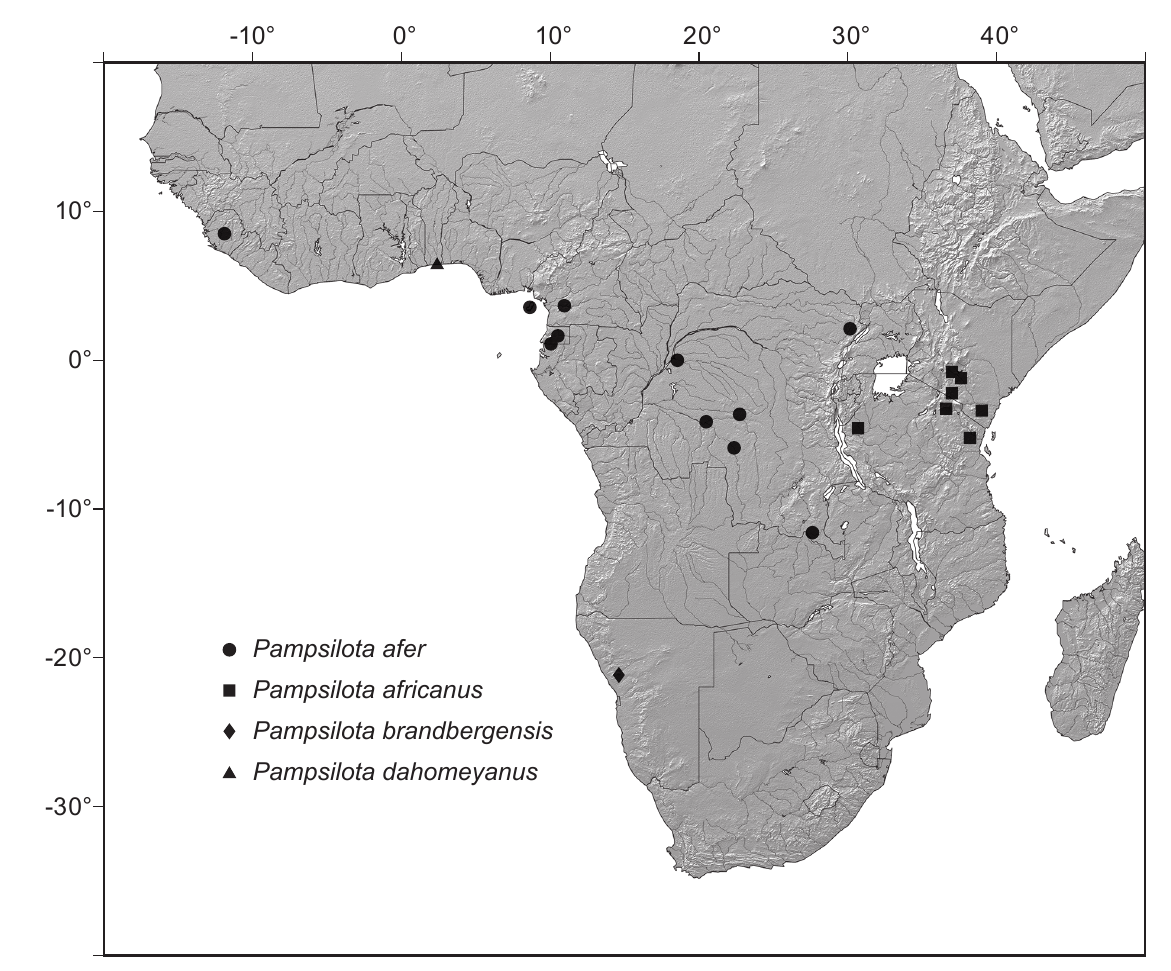
Figure 36. Distribution map for Pampsilota afer , P. africanus , P. brandbergensis , and P. dahomeyanus